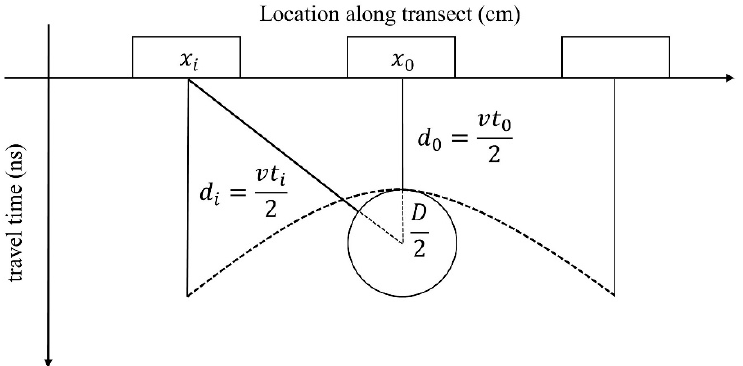
Figure 4. Detection and localisation of rhizomes using identification of by identifying hyperbolic reflections in a processed radar image. The yellow circles indicate the locations of the rhizomes as the vertices of the hyperbolic reflections.